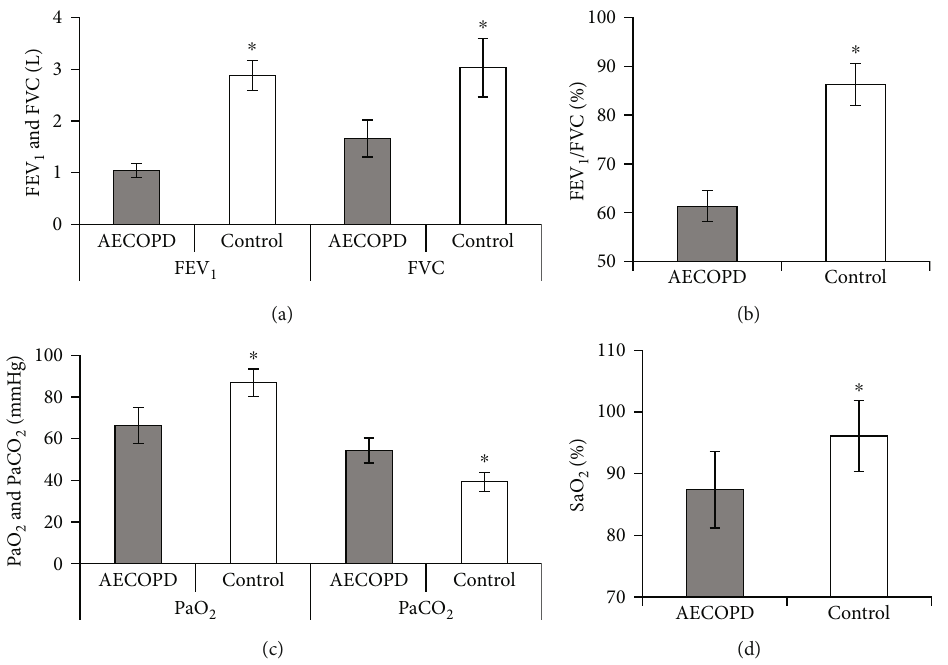
Figure 1: Comparison of PF and ABG parameters in patients. Note: (a) FEV contrast with AECOPD group, the di ff erence was statistically meaningful, ∗ P < 0 : 05 .